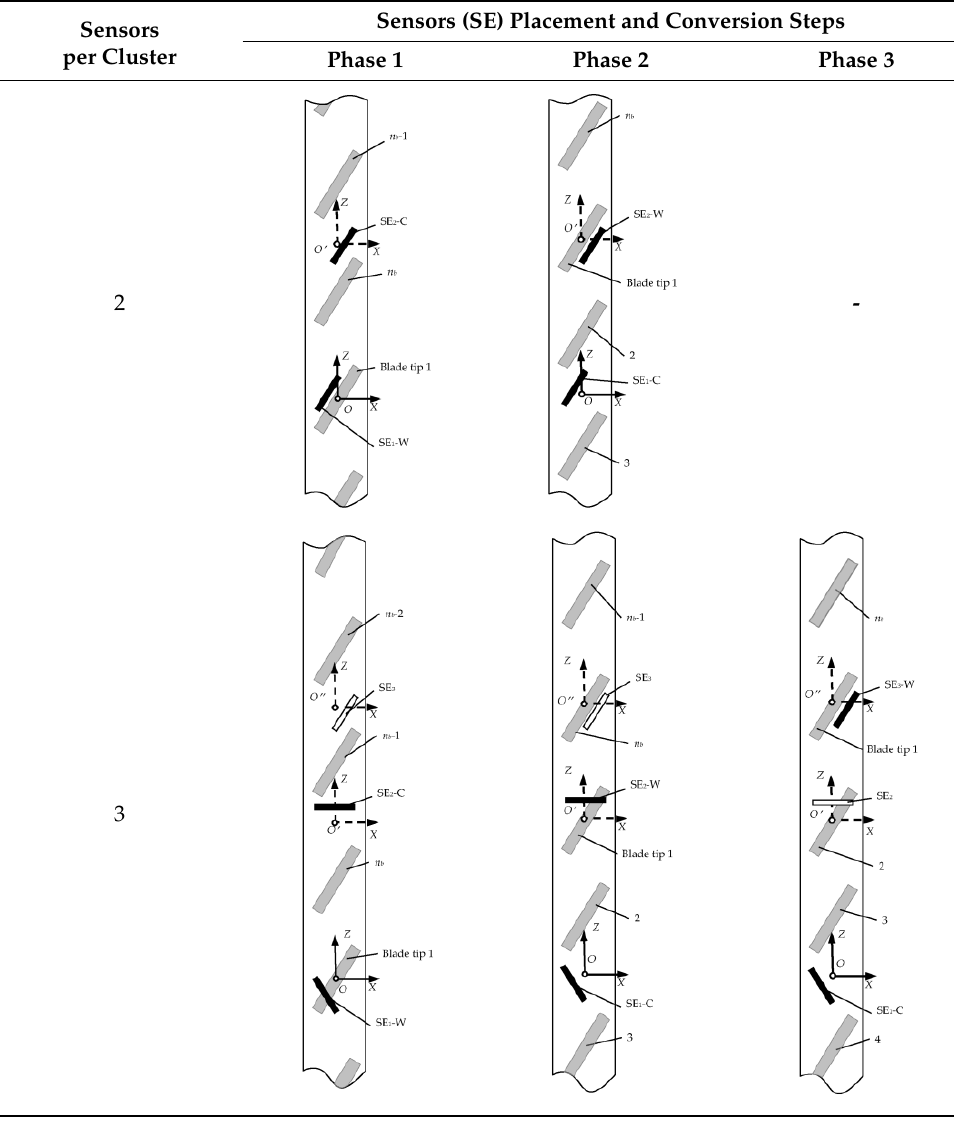
1 passes point O’, and SE 1 reverses its functions from working to compensation (SE 1 -C)